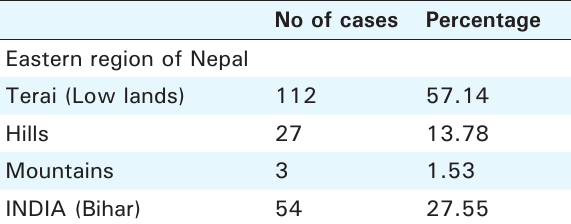
table 7. Geographic